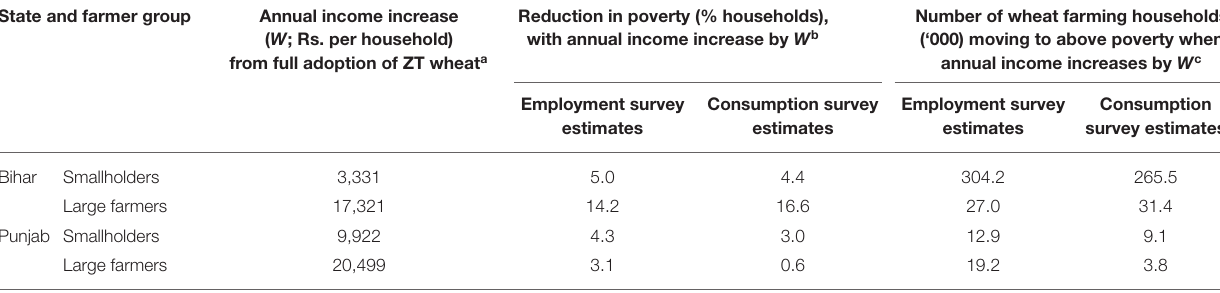
TABLE 4 | Poverty reduction potential of ZT wheat under different targeting scenarios in